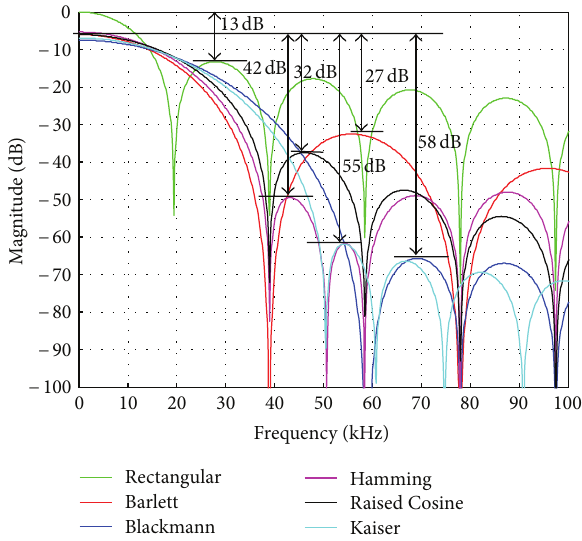
Figure 10: OFDM side lobes of a single carrier. Comparison of various window